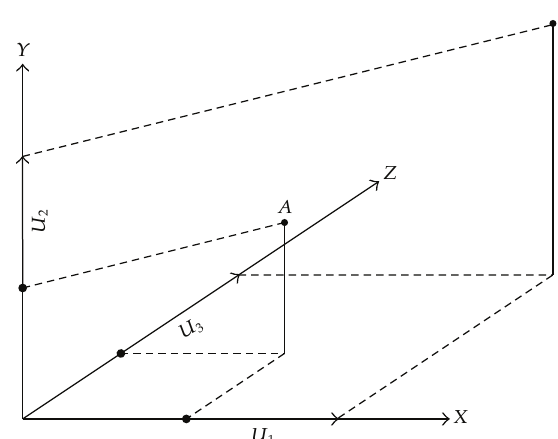
Figure 8: Definition of the displacement